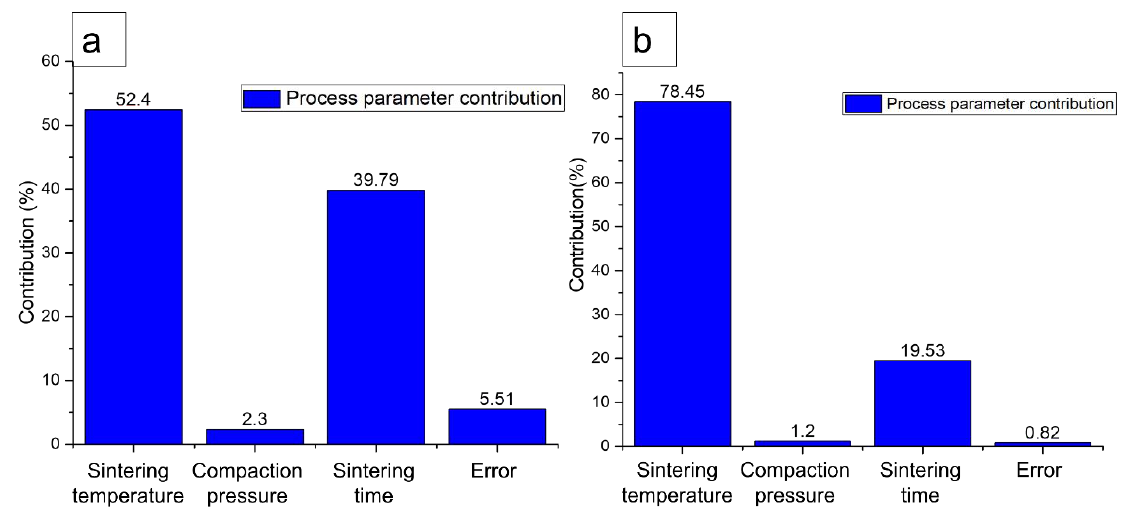
Figure 10. Percentage of the contribution of process parameters on ( a ) plateau stress and ( b ) energy absorption capacity.